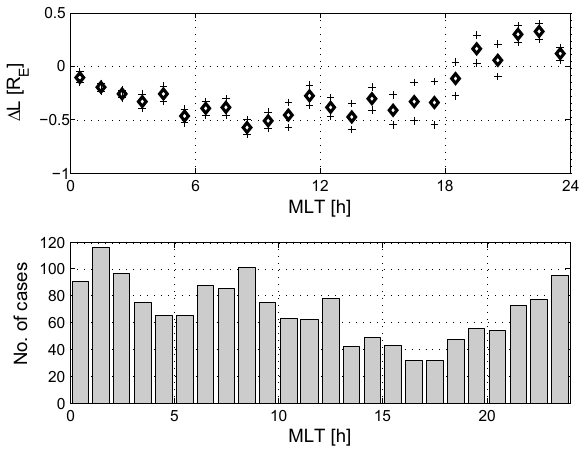
Figure 13. Mean difference between VAP PP_ N e position and Swarm SSFAC index as a function of